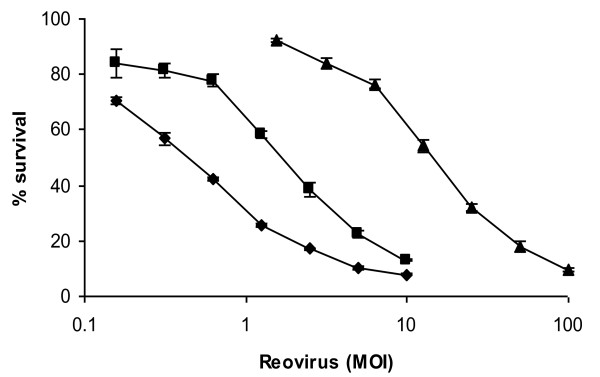
Differing sensitivities of prostate lines to reovirus infection. Prostate cell lines PC3 (diamonds), LNCaP (squares) and Du 145 (triangles) were infected with reovirus type 3 Dearing strain Reolysin at the indicated MOI for 48 h. Cell survival at this time was determined using MTS assay. Data are normalized to the uninfected control (MOI 0) for each cell line and are representative of three independent experiments.